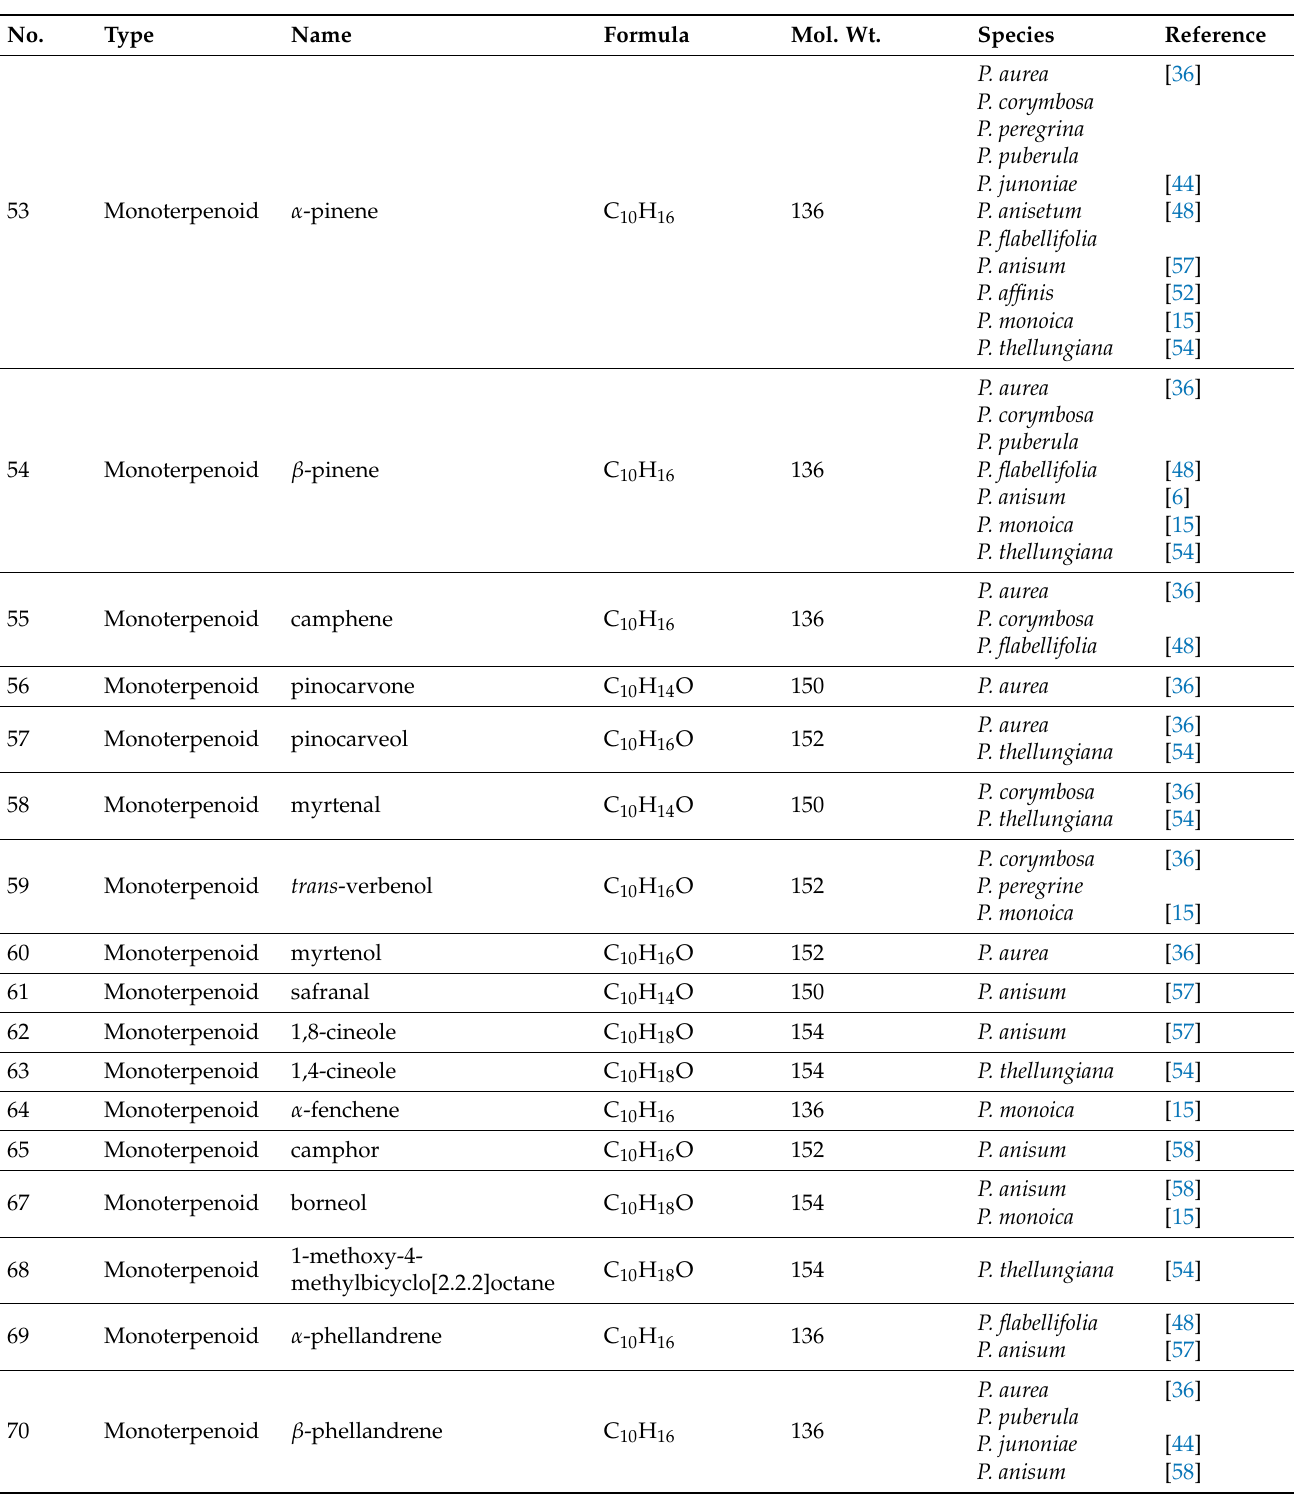
Table 3. Species of Pimpinella